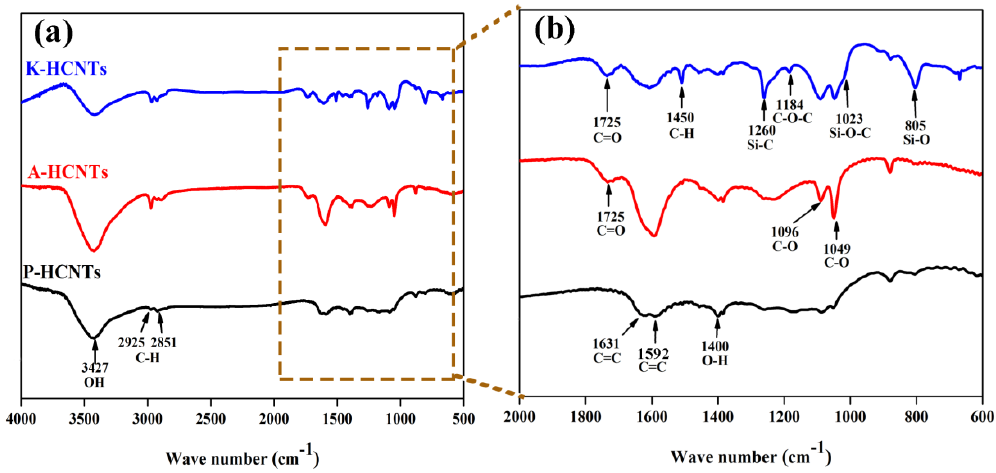
Figure 3. FTIR spectra ( a ) and magnified region of FTIR spectra from 2000 to 600 cm − 1 ( b ) for P-HCNTs, A-HCNTs and K-HCNTs.